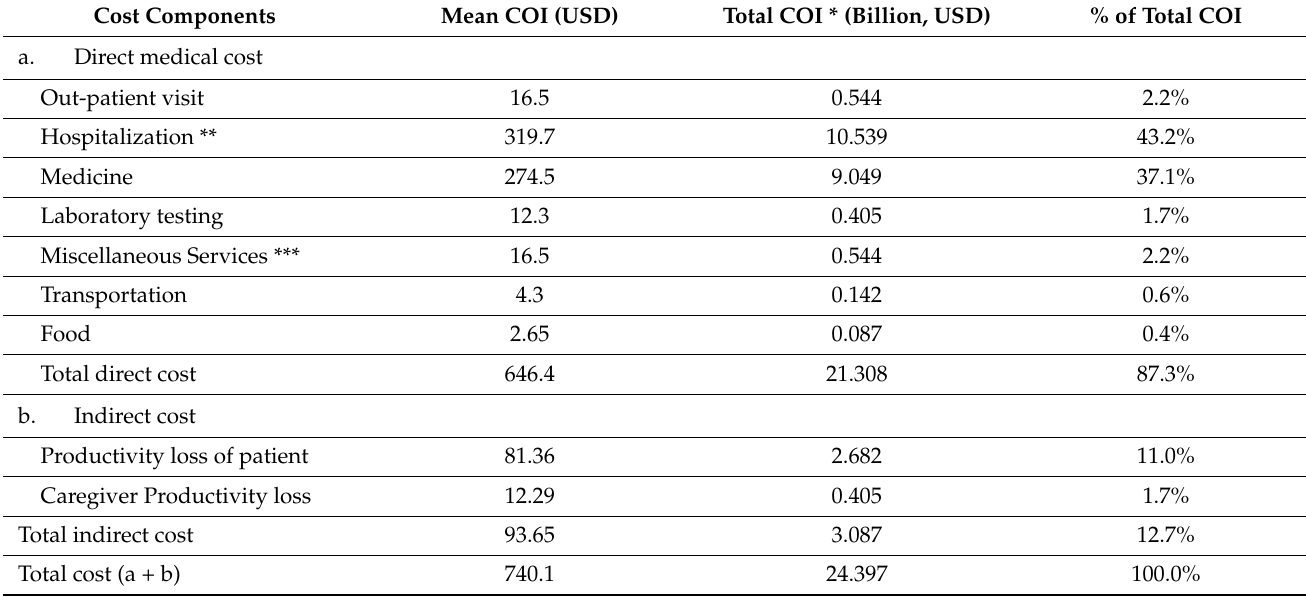
Table 2. Patients with diabetes in Pakistan: direct and indirect costs in USD.